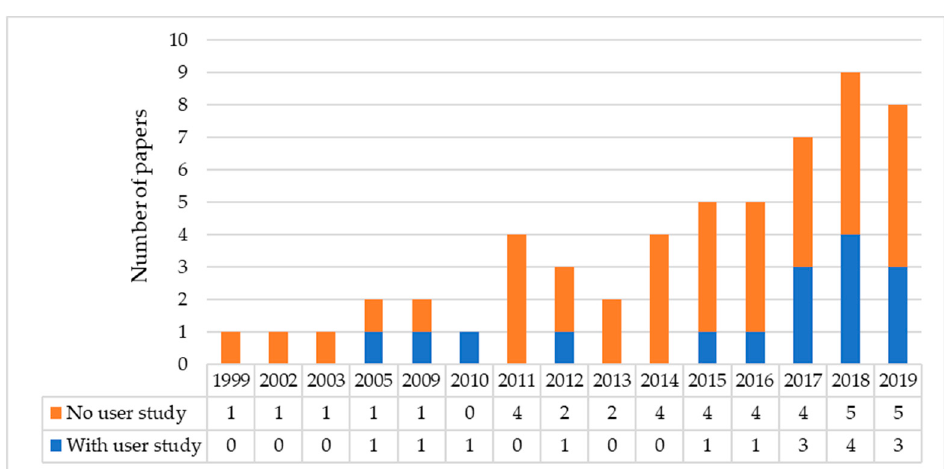
Figure 5. Distribution of the reviewed papers according to the year of publication, classified as articles with or without a user study.